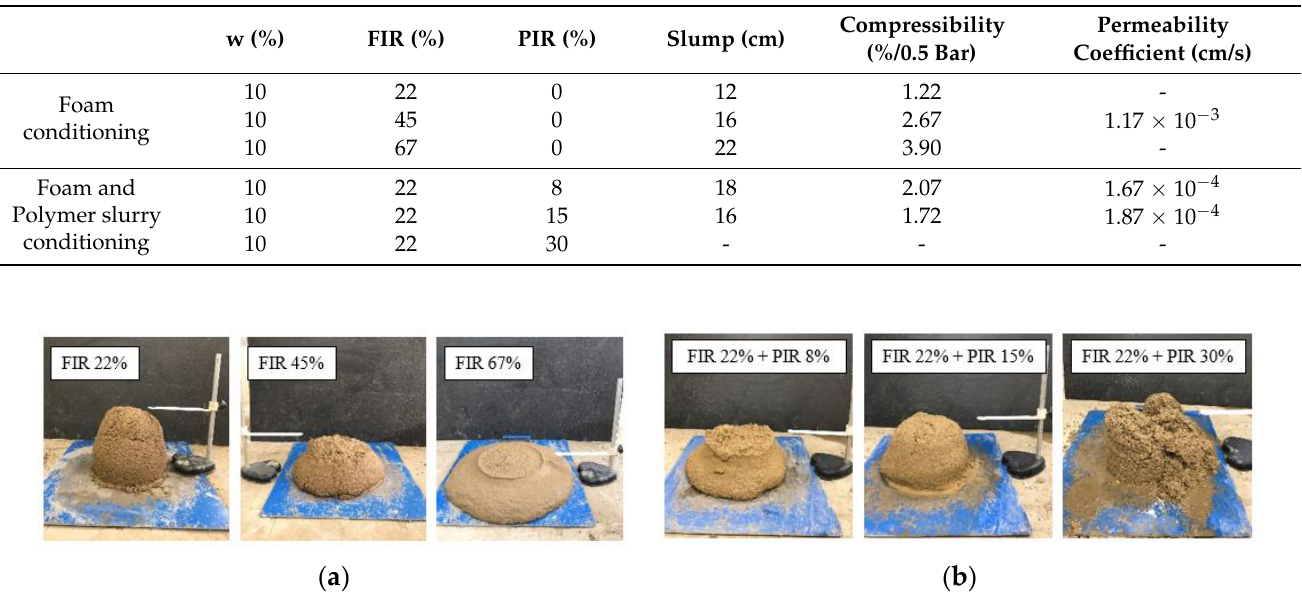
Table 5. Properties of conditioned Soil 5 depending on the mixing ratios of conditioning agents.